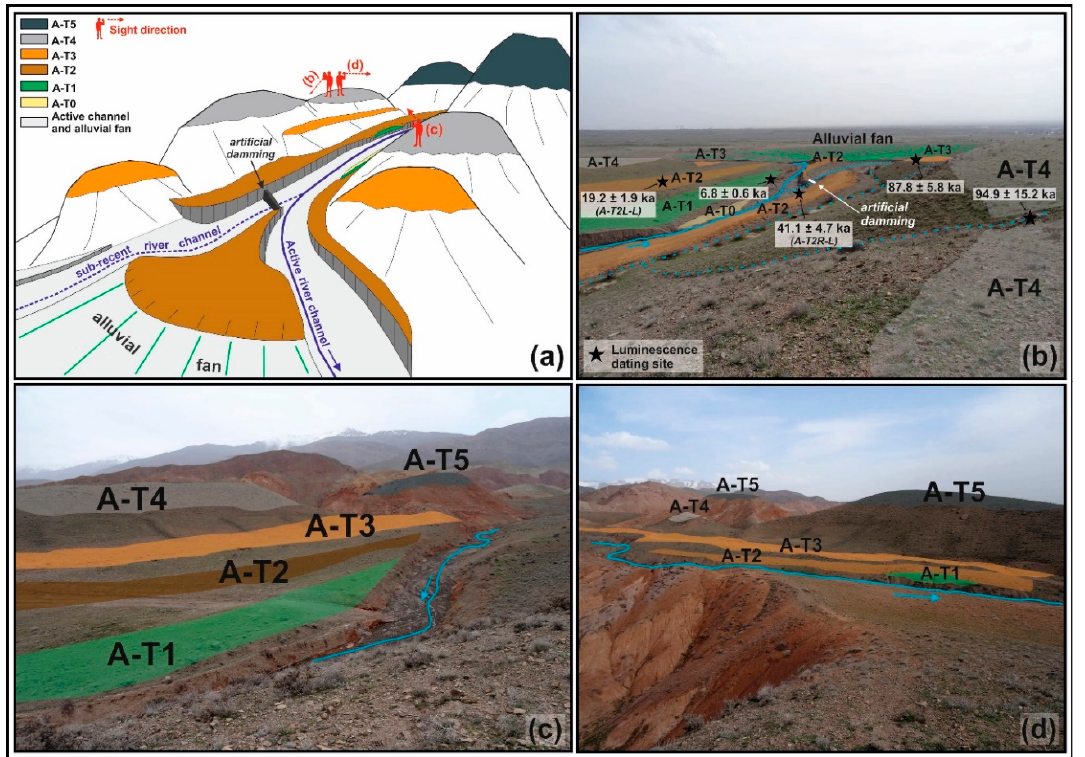
Figure 5. The studied terrace levels A-T0–A-T5 at the apex of the present-day alluvial fan with luminescence ages (location in the river system please see Figure 3). ( a ) Sketch of the terrace levels seen from the south with viewpoint directions of figures ( b – d ). ( b ) View over the terrace levels from north to south with the present-day alluvial fan in the background. ( c ) View over the terrace levels from southwest to northeast with the Binaloud Mountains in the background. ( d ) View over the terrace levels from west to east with the Binaloud Mountains in the background.